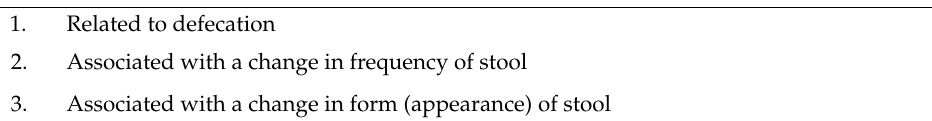
Table 1. Rome IV Criteria for IBS